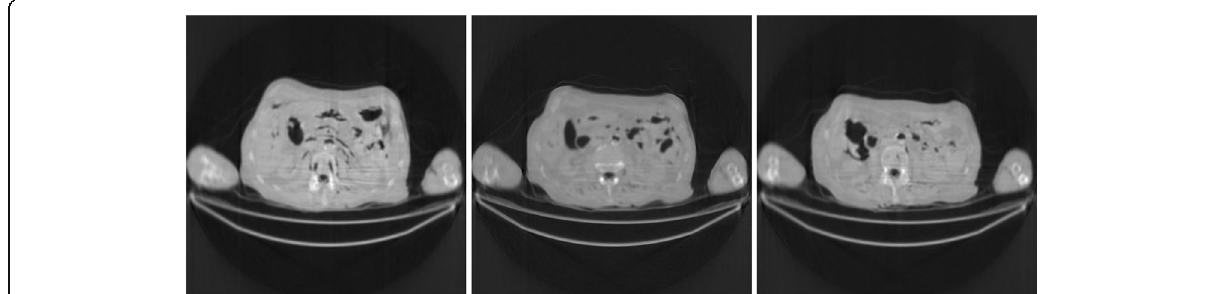
Fig. 8 FBP reconstruction of three image slices using a stationary Gaussian pre-filter h whose σ h is defined in Eq. (5) with a = 0 and c = 4. Left to Right: Slice 1, Slice 32, and Slice 64